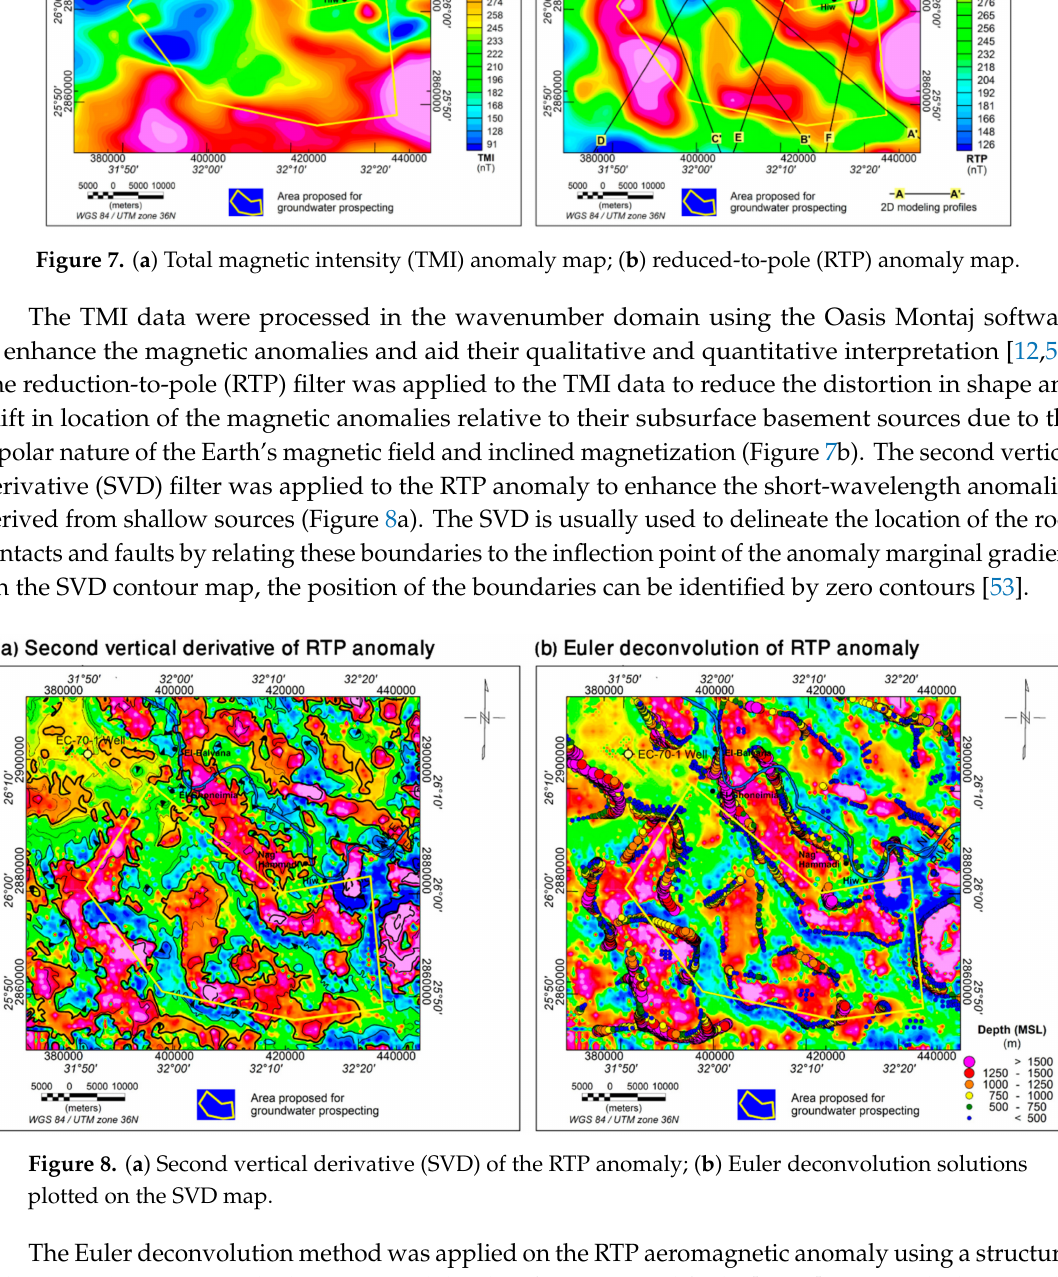
Figure 8. ( a ) Second vertical derivative (SVD) of the RTP anomaly; ( b ) Euler deconvolution solutions plotted on the SVD